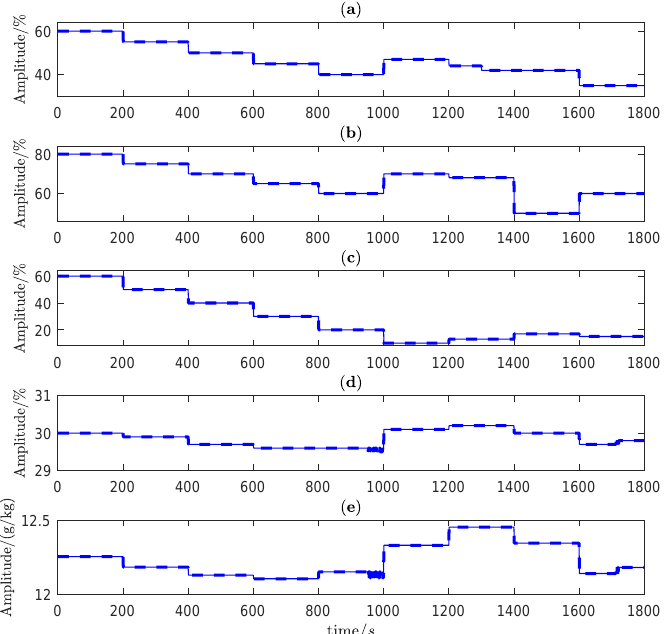
Figure 10. The measured input variables for validating optimization results: ( a ) R SA , ( b ) R CW , ( c ) R CHW , ( d ) T out and ( e ) D out .